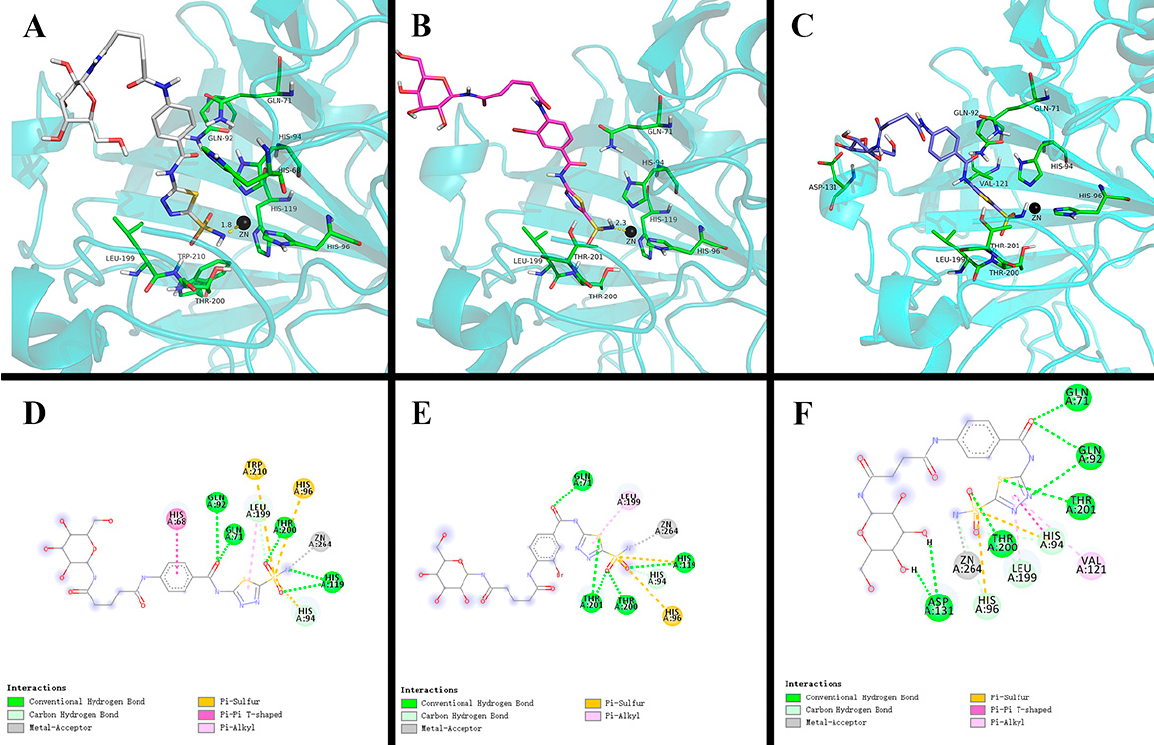
Figure 2. The modes of binding for compounds in h CA IX ( A , D ); compound 14a (grey) ( B , E ); compound 14e (pink) ( C , F ); compound 14i (blue).